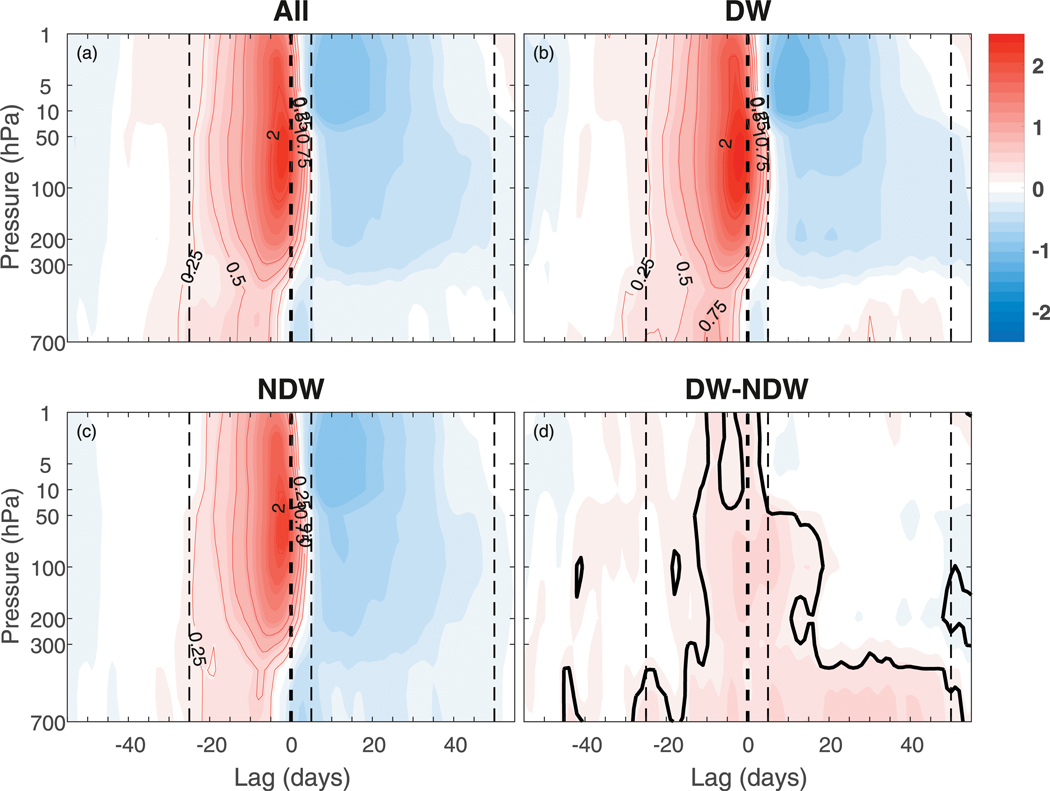
As in Fig. 1, but for the anomalous vertical component of the Eliassen–Palm flux, F(z) (see text), averaged over the latitude band of 45°–75°N and filtered for planetary waves 1 and 2. Note that F(z) has been scaled by the climatological standard deviation at each level so that the contours have units of standard deviation. Certain positive-valued contours have been added to aid in the discussion. The dashed vertical lines represent the start and end of the different lag stages used throughout the remainder of the manuscript (see text). The dashed line corresponding to zero lag has a double thickness for clarity. The thick black line in (d) represents statistical significance at the 95% level.